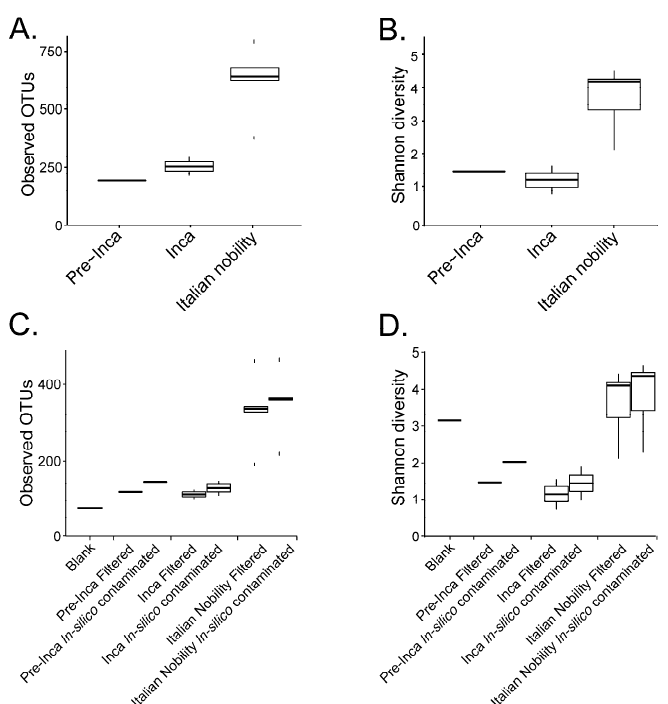
Figure 1. Alpha diversity of the mummified gut remains. Results show the alpha diversity values of the pre-Inca/Inca and Italian nobility mummies. Observed OTUs ( A ) and evenness (Shannon diversity index) ( B ) were calculated after filtering OTUs present in the blank control from the mummified microbiome (see text). Sequence files were also in-silico contaminated with the OTUs identified in the blank control to mimic cross contamination of the samples with extraction blanks. Observed OTUs ( C ) and evenness (Shannon diversity index) ( D ) were also determined for the in-silico contaminated samples. Genes 2018 , 9 , x